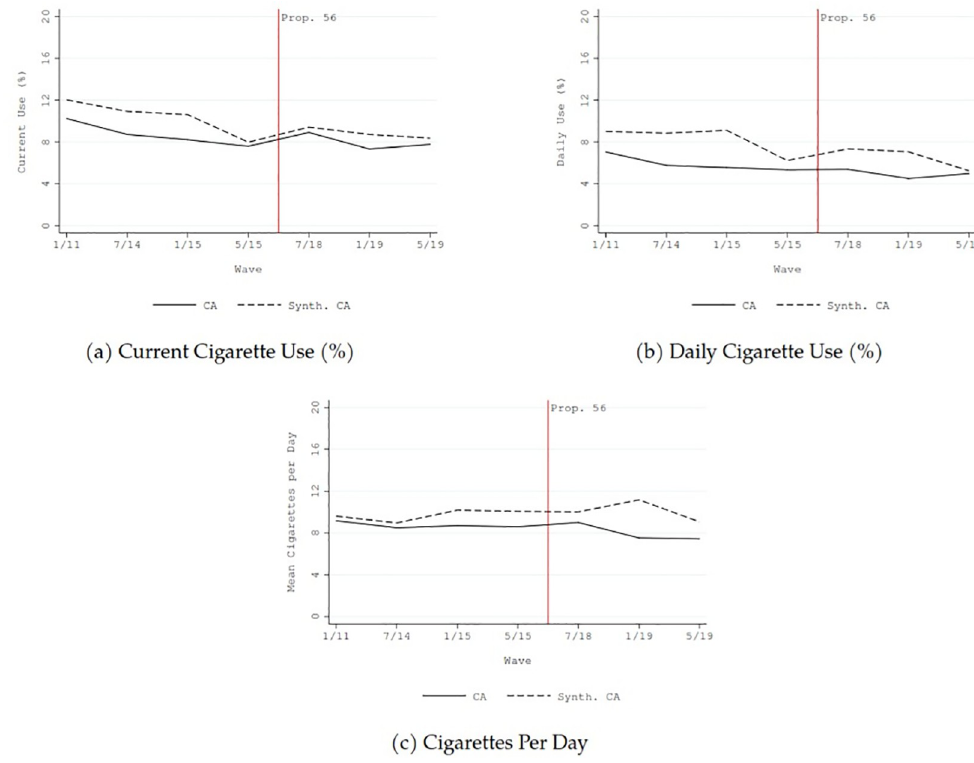
Fig 2. Comparison before and after the implementation of California Proposition 56 tobacco tax increase between California and synthetic control: Cigarette use outcomes.